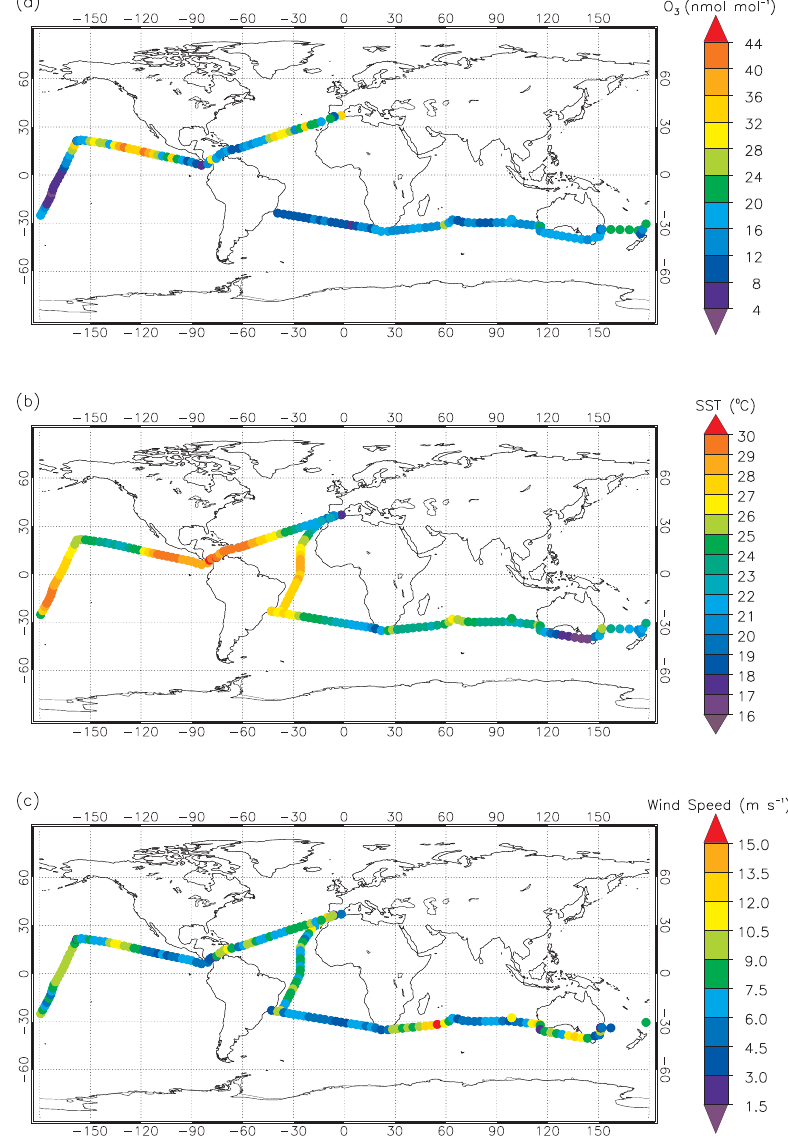
Figure 1. Observations of surface ozone and ancillary parameters during Malaspina 2010 (daily average): (a) O 3 mixing ratios, (b) sea surface temperature and (c) wind speed; see also Table 2.